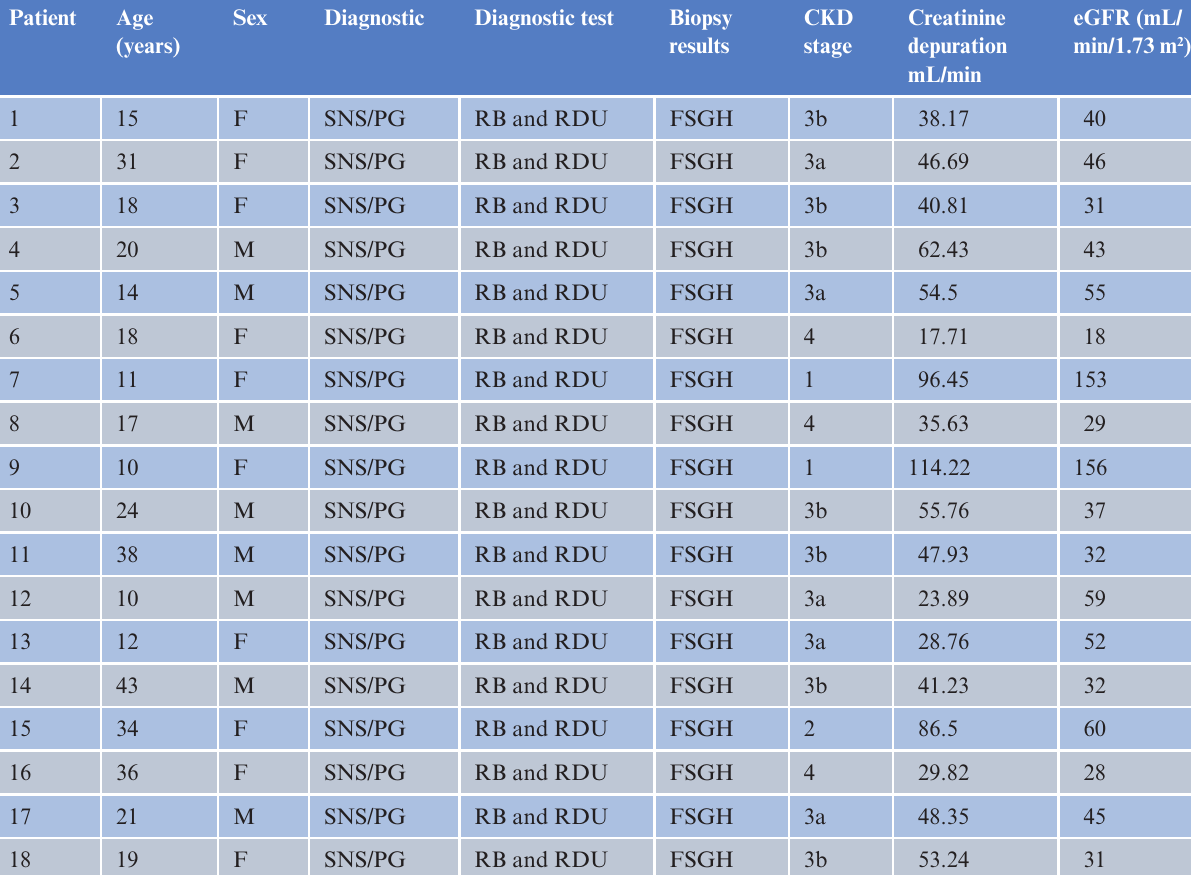
Table 1. Patient characteristics at